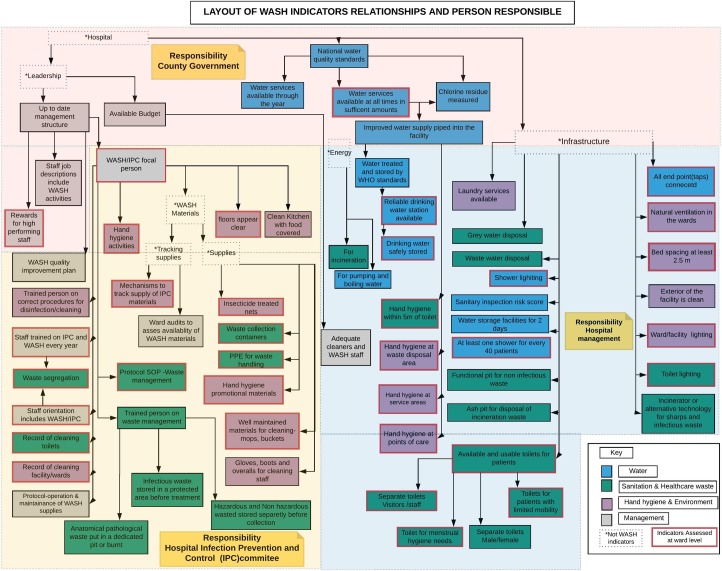
Schematic layout of WASH FIT indicators.Illustrates how indicators assessed at ward and facility level are logically related. These are grouped by the original 4 domains and by levels of responsibility. The indicators with a red bold outline were also assessed at ward level. The dotted boxes are used to describe categories and are not part of the indicators.